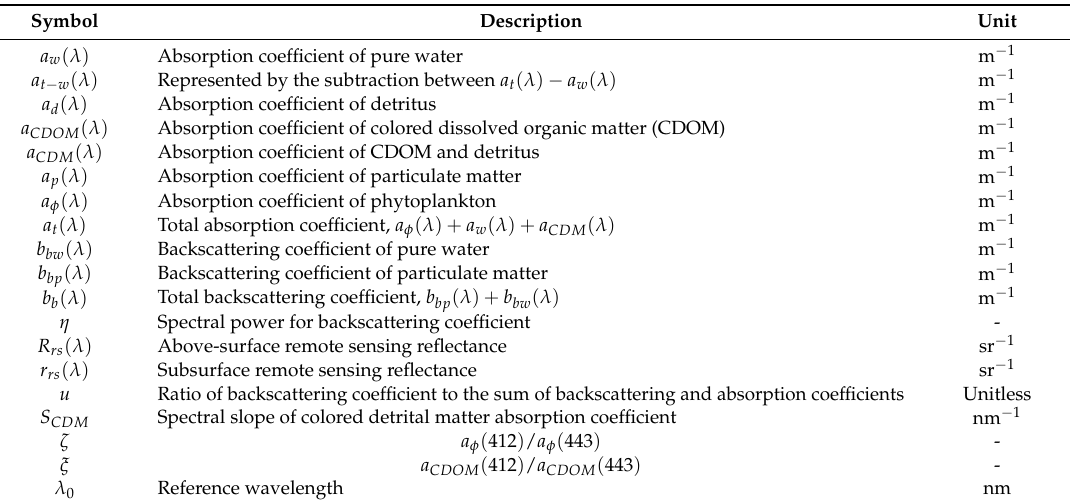
Table 1. List of symbols and